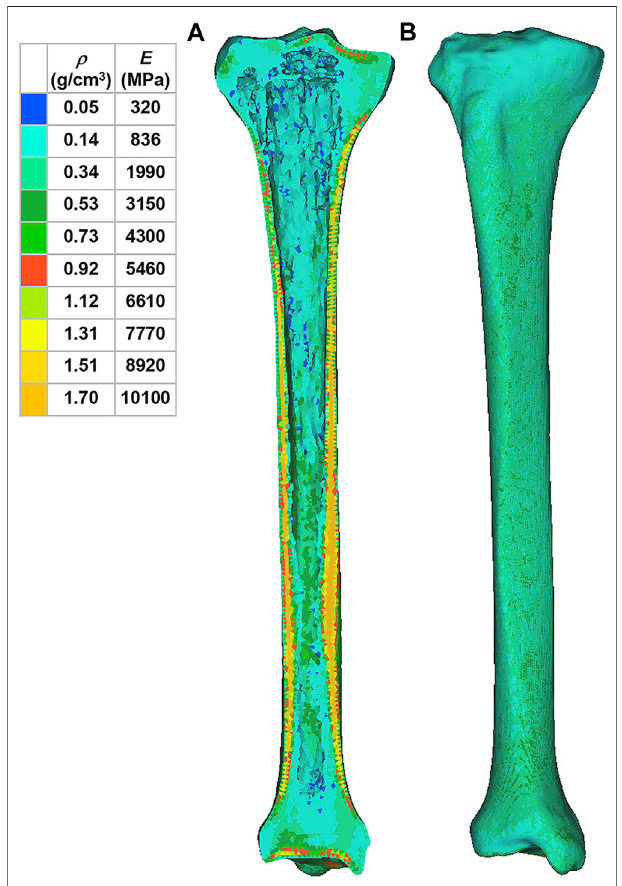
FIGURE 2 | Material properties of the inhomogeneous tibia. (A) Internal material properties of the tibia. (B) External material properties of the tibia. ρ : bone density. E : elastic modulus.